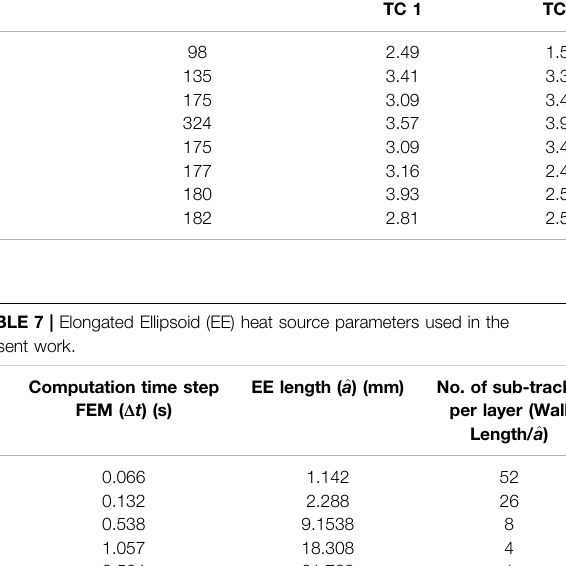
Frontiers in Materials |